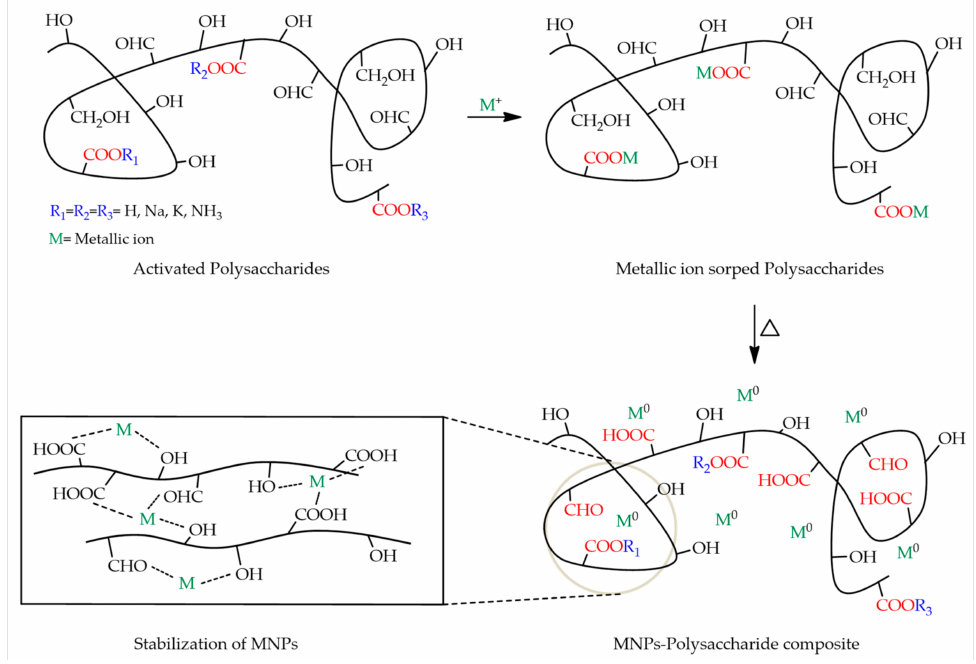
Figure 3. Representation of polysaccharides acting as reducers and stabilizers of metal nanoparticles. As depicted in Figure 3, polysaccharides host metal ions through noncovalent bonding (sorption). The as-formed metallic precursor is then reduced to a zero-valent state, starting nucleation and nanocrystal growth simply by altering the order of free energy